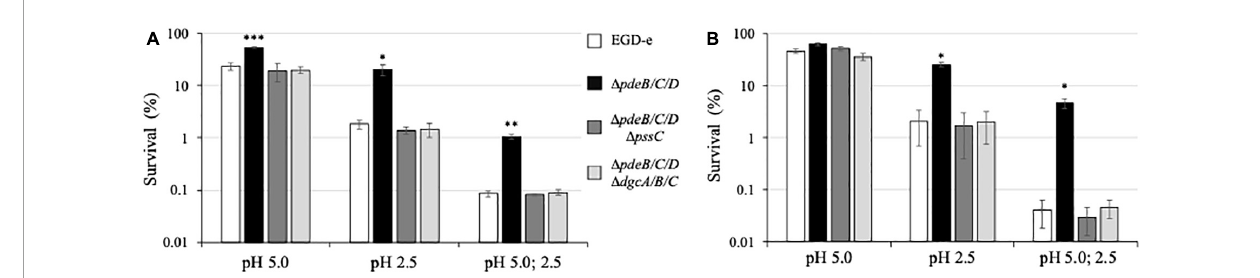
FIGURE6 Survival under acid stress of the L. monocytogenes biofilms. The 48-h old biofilms formed on pieces of cantaloupe pulp (A) and celery (B) were exposed for 15 min to pH 5.0 or pH 2.5, or sequentially to pH 5.0 (15 min) and pH 2.5 (15 min). Following medium neutralization, cantaloupe and celery pieces were collected, homogenized, and CFU were enumerated. For each strain, survival percentages were calculated based on the initial CFU prior to exposure to acid (assigned to 100%). The average initial CFUs for all strains were within the range of (5.3–7.3) × 10 9 per cantaloupe pulp piece and (1.1–1.4) × 10 9 per celery piece. Significant differences, compared to EGD-e, are indicated as follows: ∗ P < 0.05, ∗∗ P < 0.01, and ∗∗∗ P <